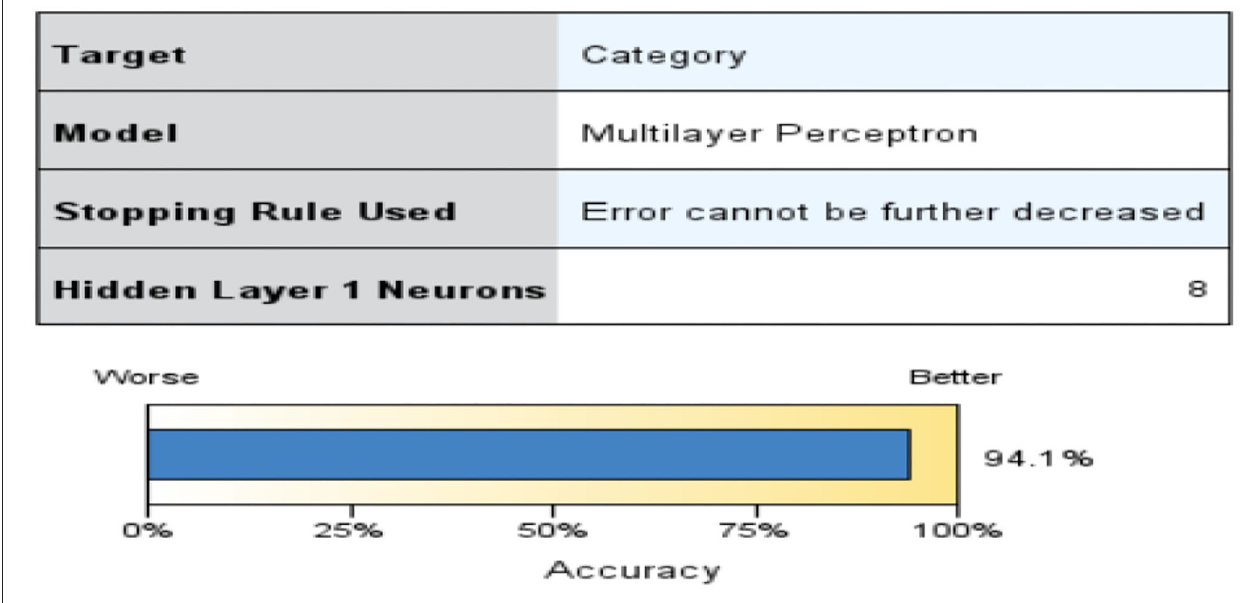
FIGURE 2 | MLP Accuracy.